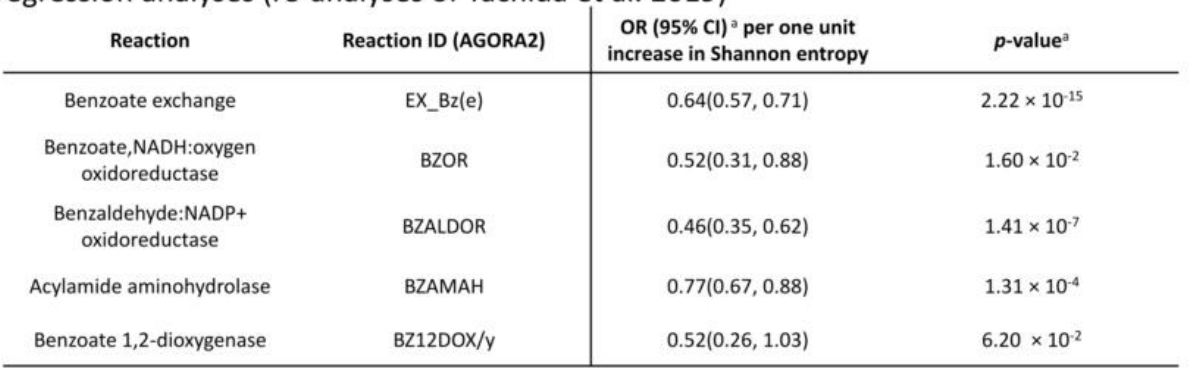
Figure 4. Overview of the results regarding reaction abundances after functional annotation of the Yachida et al. dataset using AGORA2. ( A ) Scatter plots of reaction abundances against the Shannon entropy of metagenomes after mapping onto AGORA2. A red line indicates the linear regression line, where the dashed red lines display the 95% confidence interval. All displayed associations had a false discovery rate < 0.05. ( B ) Table displaying the reaction abundance Shannon entropy associations for benzoate-producing, -degrading, or -transporting reactions noted in AGORA2. OR — odds ratio; 95% CI — 95% confidence interval.